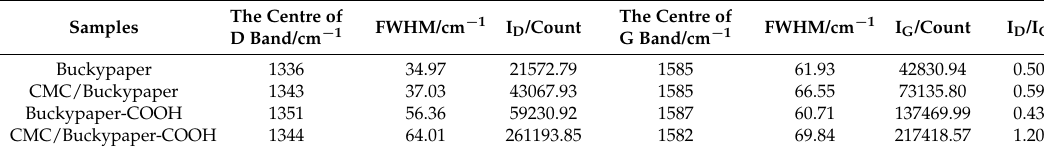
Figure 5. Raman spectra recorded for ( a ) a buckypaper with different CNTs weight and ( b ) different kinds of buckypaper. Table 1. Main parameters of the characteristic Raman spectras.